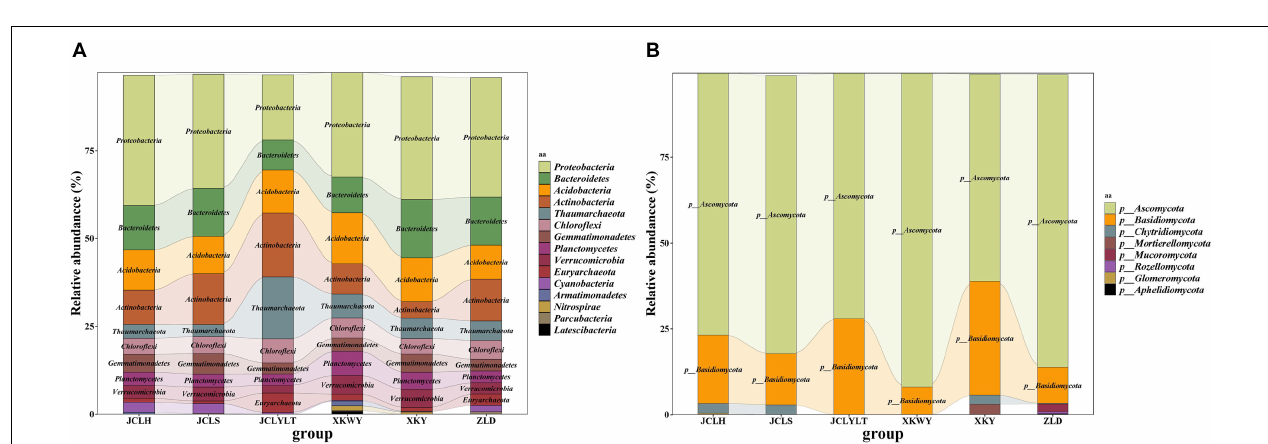
FIGURE 2 | Four kinds of common morphological characteristics of diseased Populus euphrasae in XKY, ZLD, and JCL are shown in (A–D) . The endophytic fungi isolated and identified from (A–D) are shown in (E–N) .